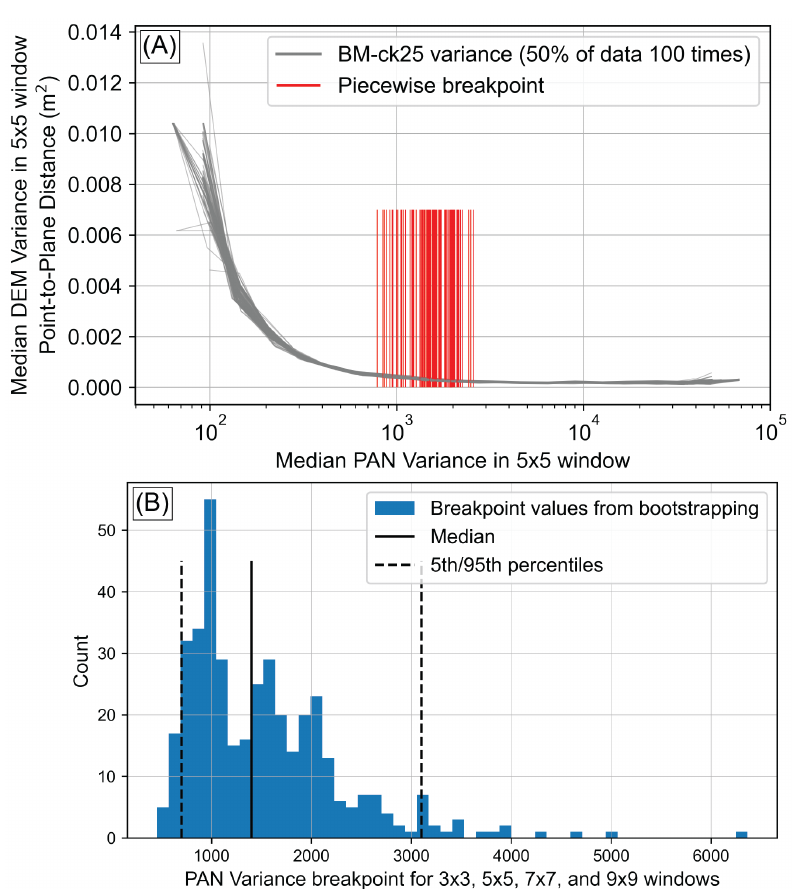
Figure 10. ( A ) Piecewise fitting, using two linear segments, carried out on 50% of blocked values shown in Figure 7D, bootstrapped 100 times (with replacement). The vertical red lines represent the breakpoints found in each fitting iteration. Results are shown for the BM-ck25 DEM and 5 × 5 pixel variance window calculations. Note a linear y-scale is used here (as opposed to the logarithmic scale in Figure 8) to highlight the steep limb and plateau in the piecewise fitted relationship; ( B ) histogram of breakpoints taken from all variance window sizes (3 × 3, 5 × 5, 7 × 7, and 9 × 9 pixels) and iterations of piecewise fitting (n = 400 breakpoints), with median (1300 PAN variance) and 5th/95th percentiles